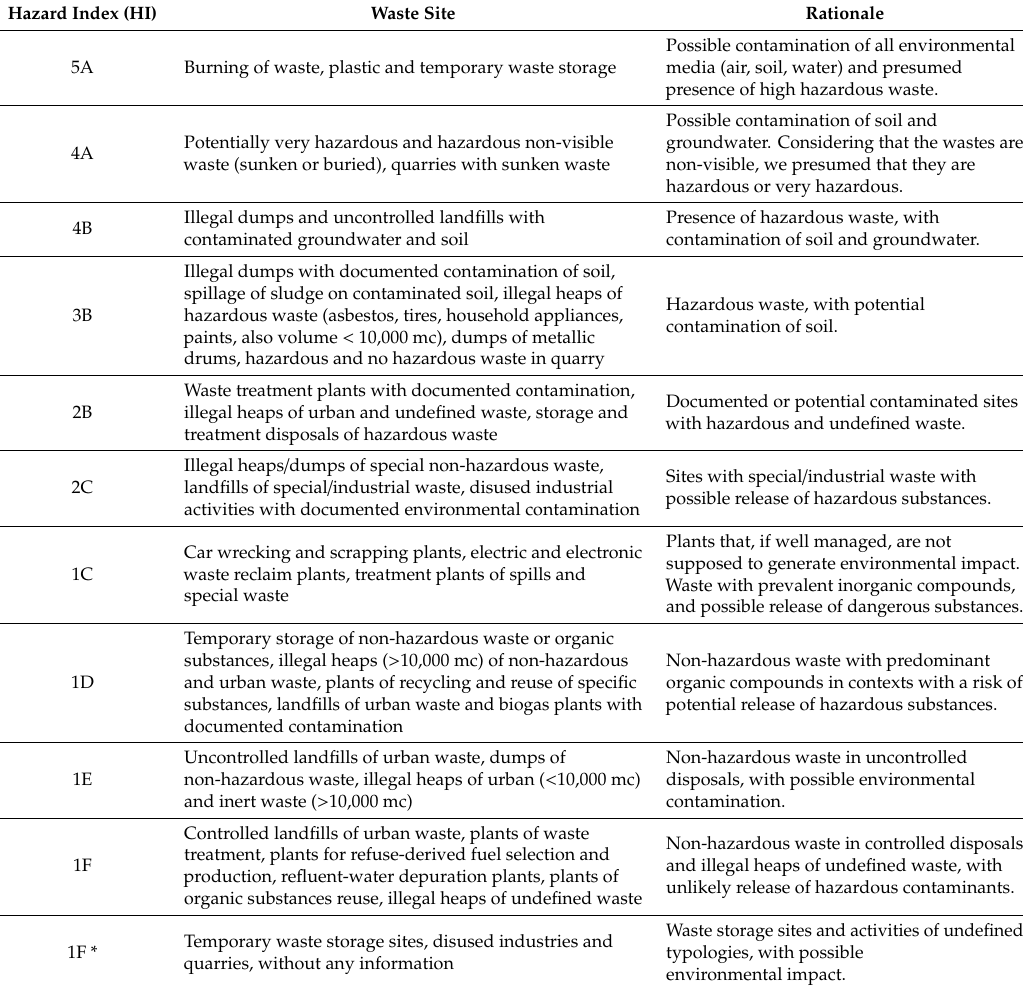
Table 1. Site-specific hazard index (HI), by waste